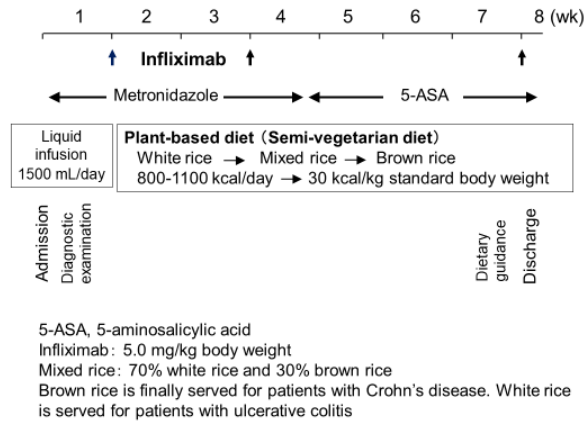
Figure 10. Protocol of infliximab and a plant-based diet as first-line (IPF) therapy.